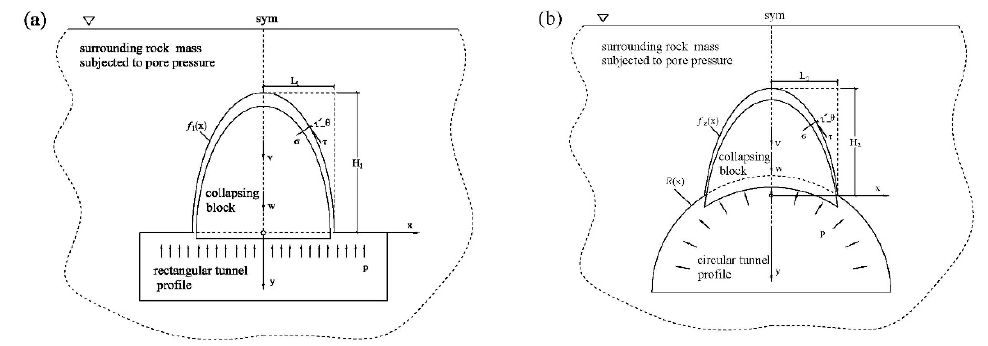
Figure 1. Collapse pattern with pore pressure for: ( a ) rectangular tunnel; ( b ) circular tunnel.